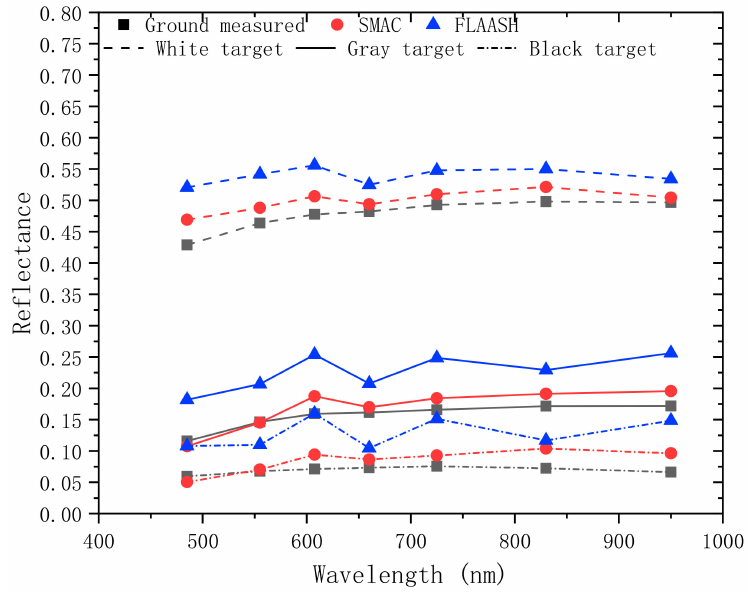
Figure 18. The average surface reflectance of white, gray, and black targets in the corrected image of